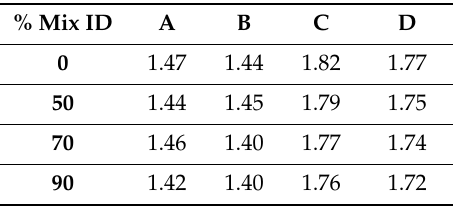
Table 3. Fresh density results (gr / cm 3